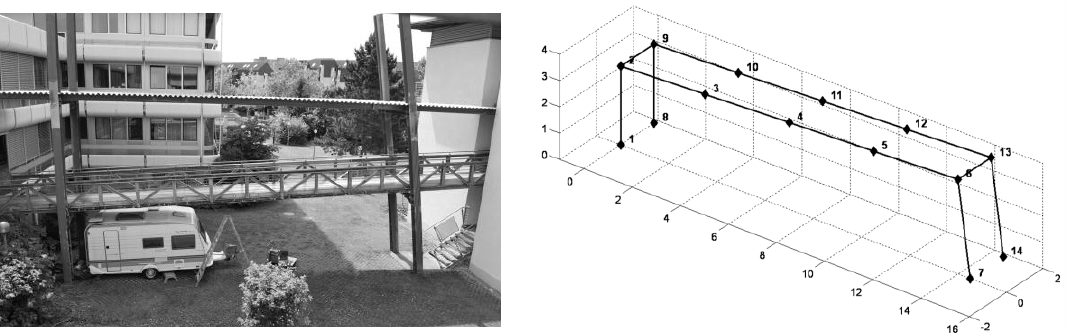
Fig. 1. Pedestrian Steel Bridge and corresponding geometry